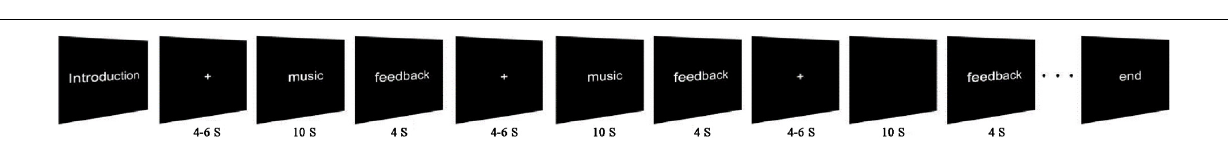
FIGURE 2 | Experimental task. In each trial, the musical stimuli (10 pieces from Chinese musical pieces and 10 from Western musical pieces) and the control stimuli (10-s blank period) were presented in a pseudorandom order after presentation of a fixation cross for 4–6 s. The participants were instructed to provide feedback on their level of familiarity with music styles (familiar, ordinary, and unfamiliar) by using a keyboard within 4